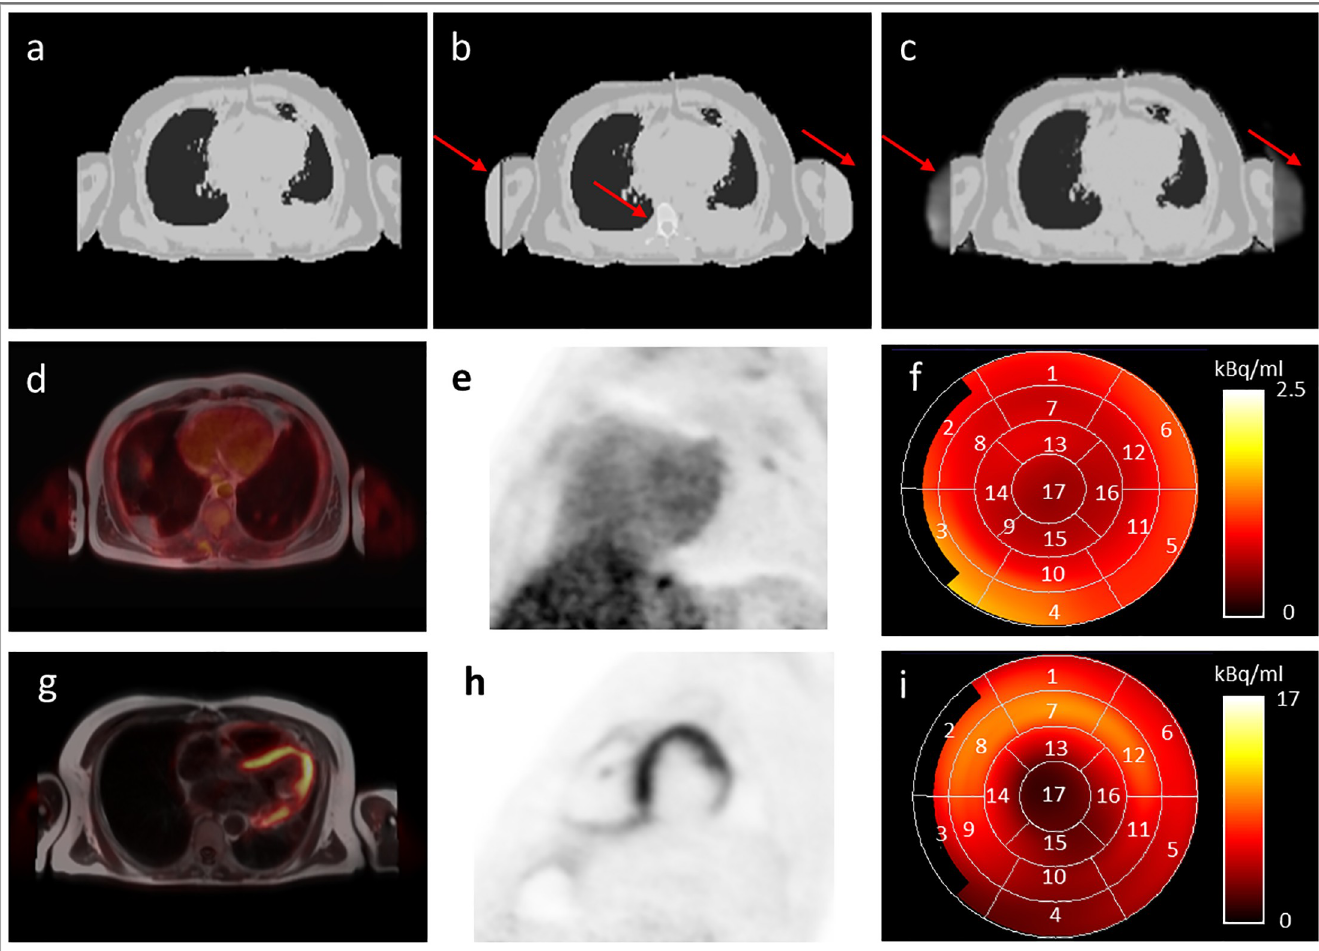
Fig 1. Overview of AC-maps, cardiac PET data and polar plots. Attenuation correction (AC) maps based on Dixon-VIBE sequence (a), the extended Dixon-VIBE sequence additionally using HUGE truncation correction and bone information (b), and the extended Dixon-VIBE sequence additionally using PET-based MLAA information (c). Red arrows depict differences between Dixon-VIBE only AC and improved AC-maps using HUGE, bone segmentation, and MLAA, respectively (b, c). Patient example studied in the fasted state (d-f) and patient example studied with a viability protocol (g-i) are shown. PET/MR fusion image (d, g) and PET short axis view (e, h) of the heart. A 17-segment polar plot (f, i) of the short-axis of the left ventricle was generated for each patient and each PET data reconstruction to evaluate the quantitative effect of improved AC on cardiac PET imaging. Numbers 1–17 are assigned to the 17 individual cardiac segments according to the American Heart Association standard for cardiac polar